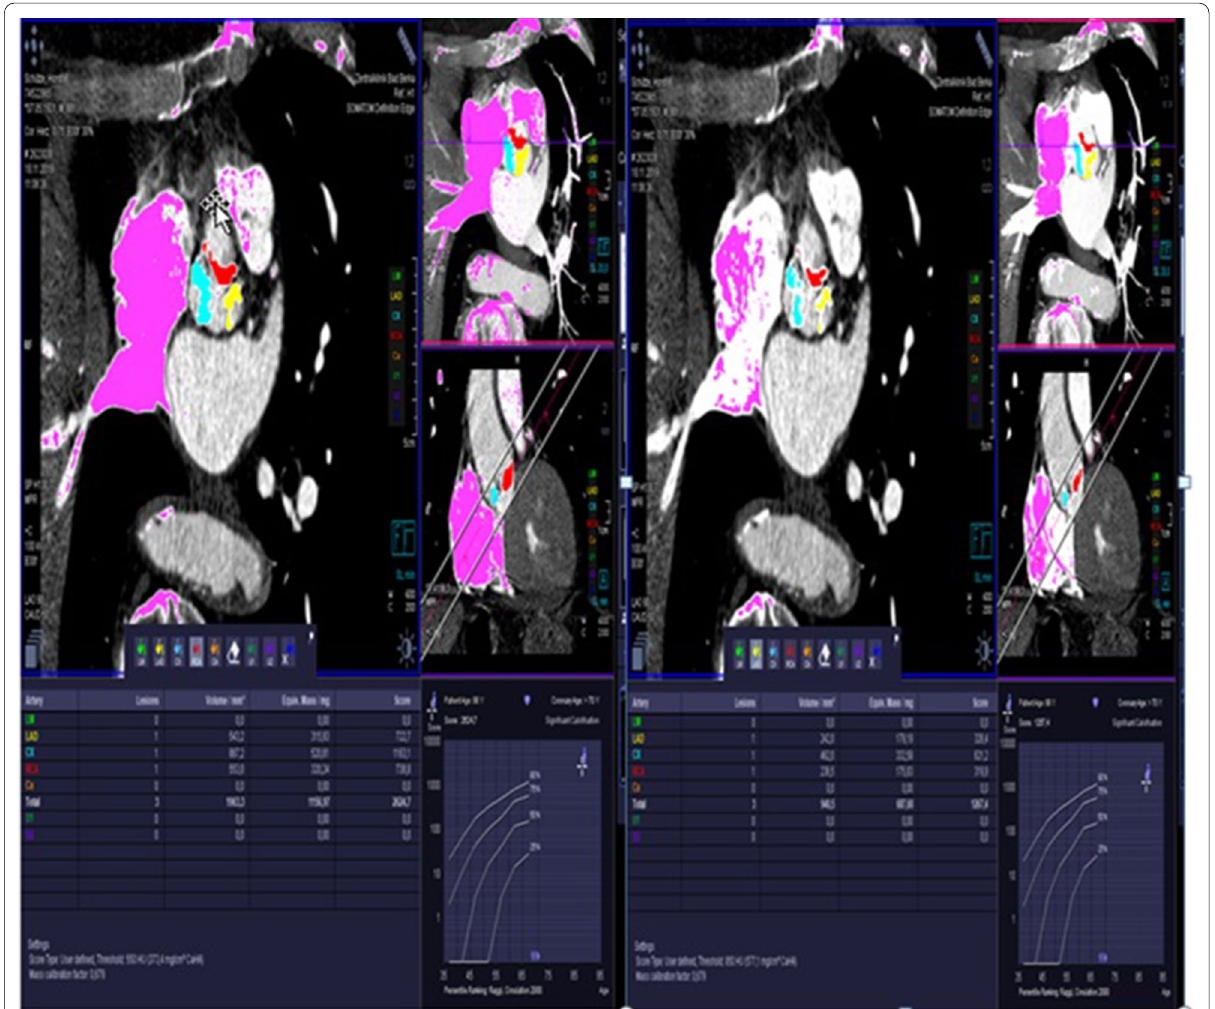
Fig. 1 Calcium score and volume measurement use different HU threshold leads to change the score and volume significantly (to the right with 850 HU threshold and to the left with modifiable